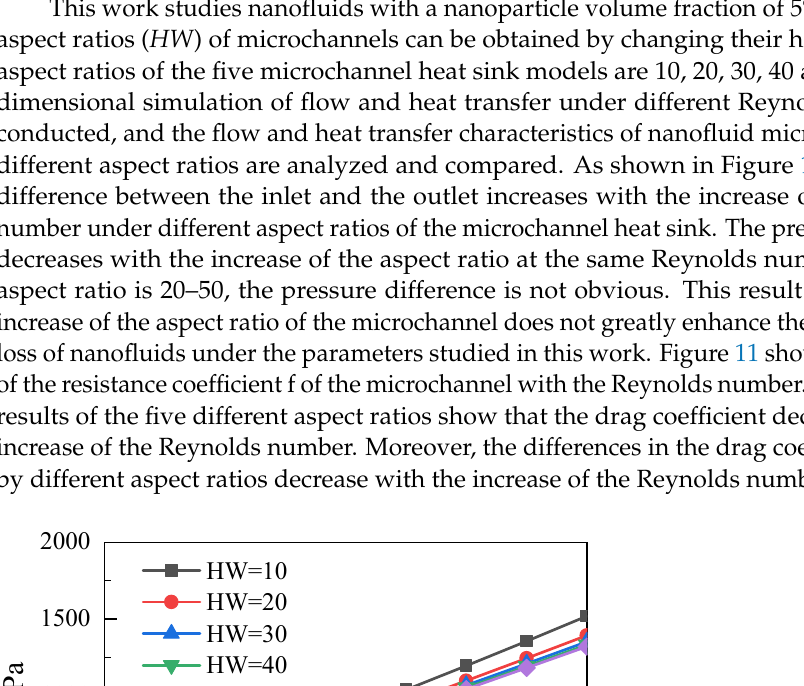
Figure 9. Effects of nanoparticle volume fraction on pumping power.